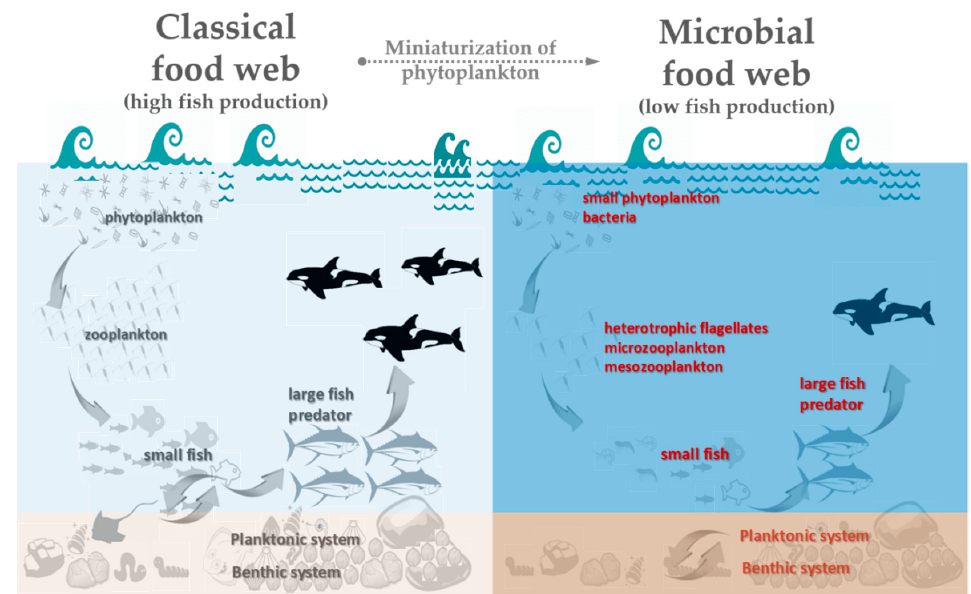
Figure 11. Changes in the food chain due to succession of the phytoplankton community in the northern East China Sea.